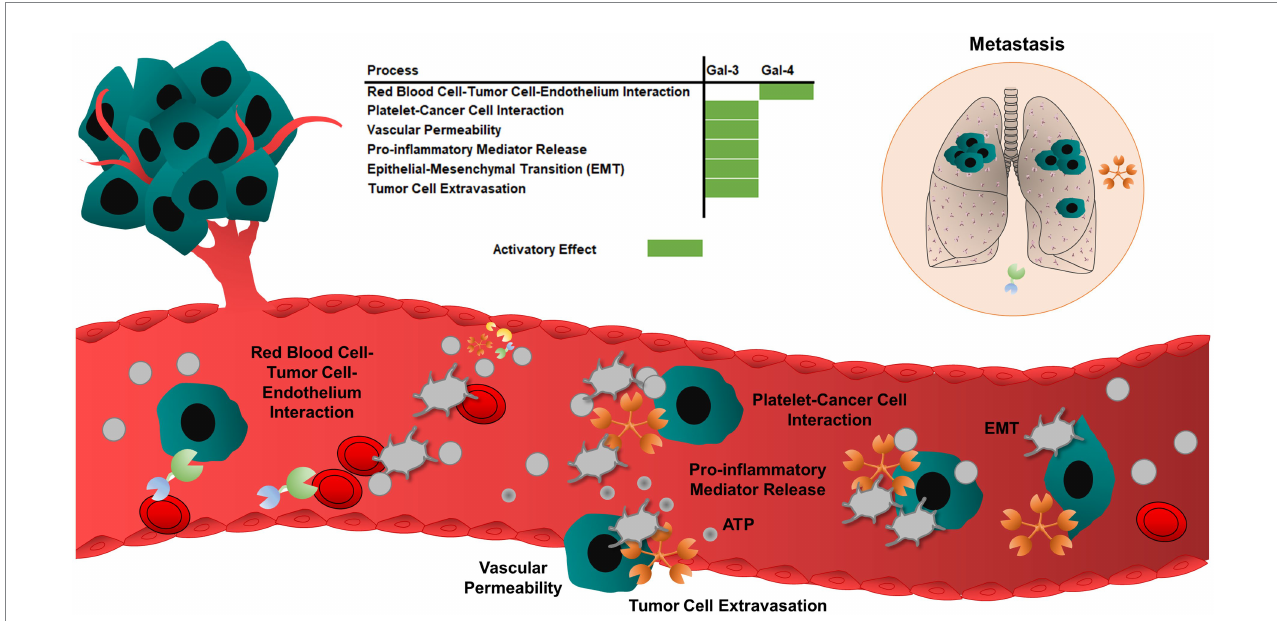
FIGURE 4 Invasive cancer cells enter into the blood circulation where they can build physical and functional interactions with platelets, red blood cells, and vascular endothelium. These interactions support the metastatic spread of cancer cells, thereby inducing their survival and proliferation at distant organs. Hematogenous metastasis is strongly influenced by tumor-resident galectins (galectin-3 and galectin-4) that interact with glycoproteins on the surface of platelets and red blood cells. Galectin-3 promotes platelet adhesion and activation through binding to platelet GPVI, thereby enhancing tumor cell extravasation and subsequent metastasis. These interactions also contribute to the epithelial-mesenchymal transition and pro-inflammatory phenotype, further sustaining the invasive and metastatic potential of cancer